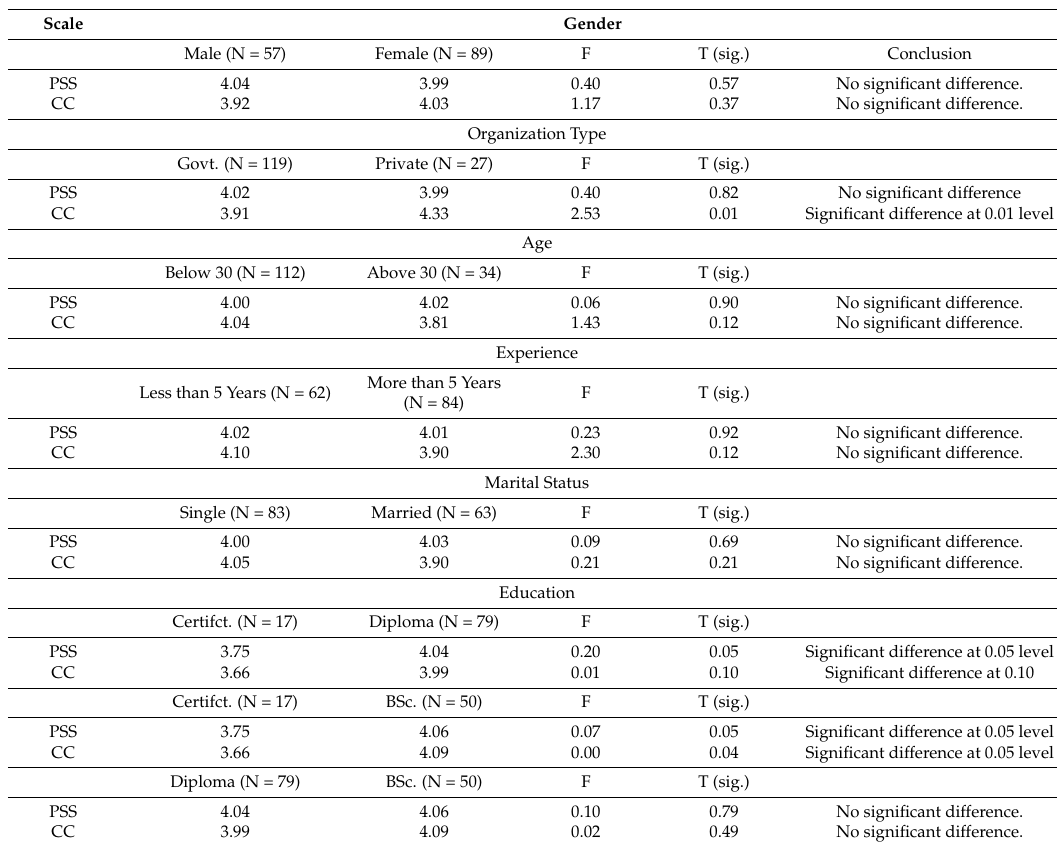
Table 4. Independent sample t -test for mean scores of respondents on perceived social support (PSS) and career commitment